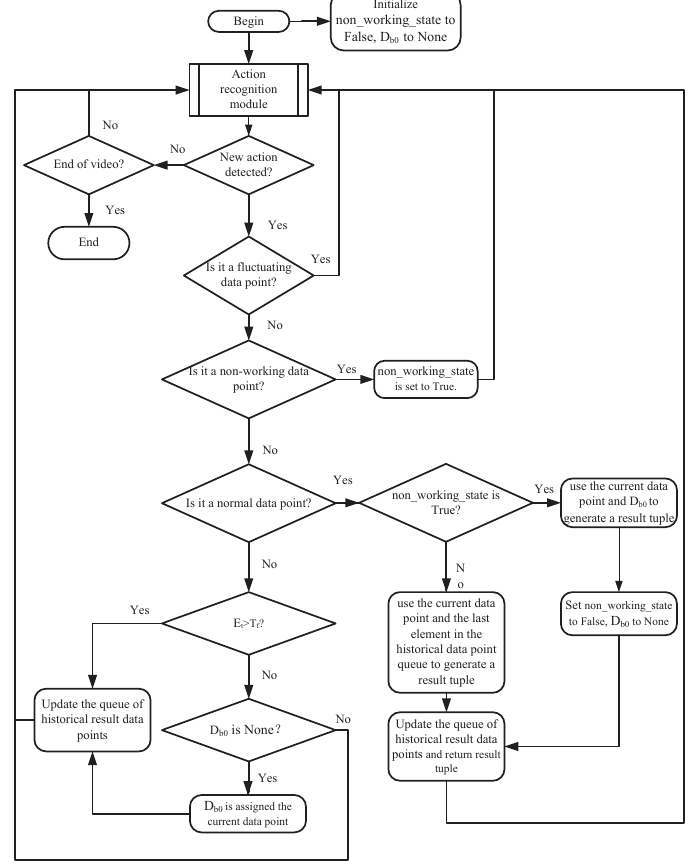
Figure 6. The processing flow of action